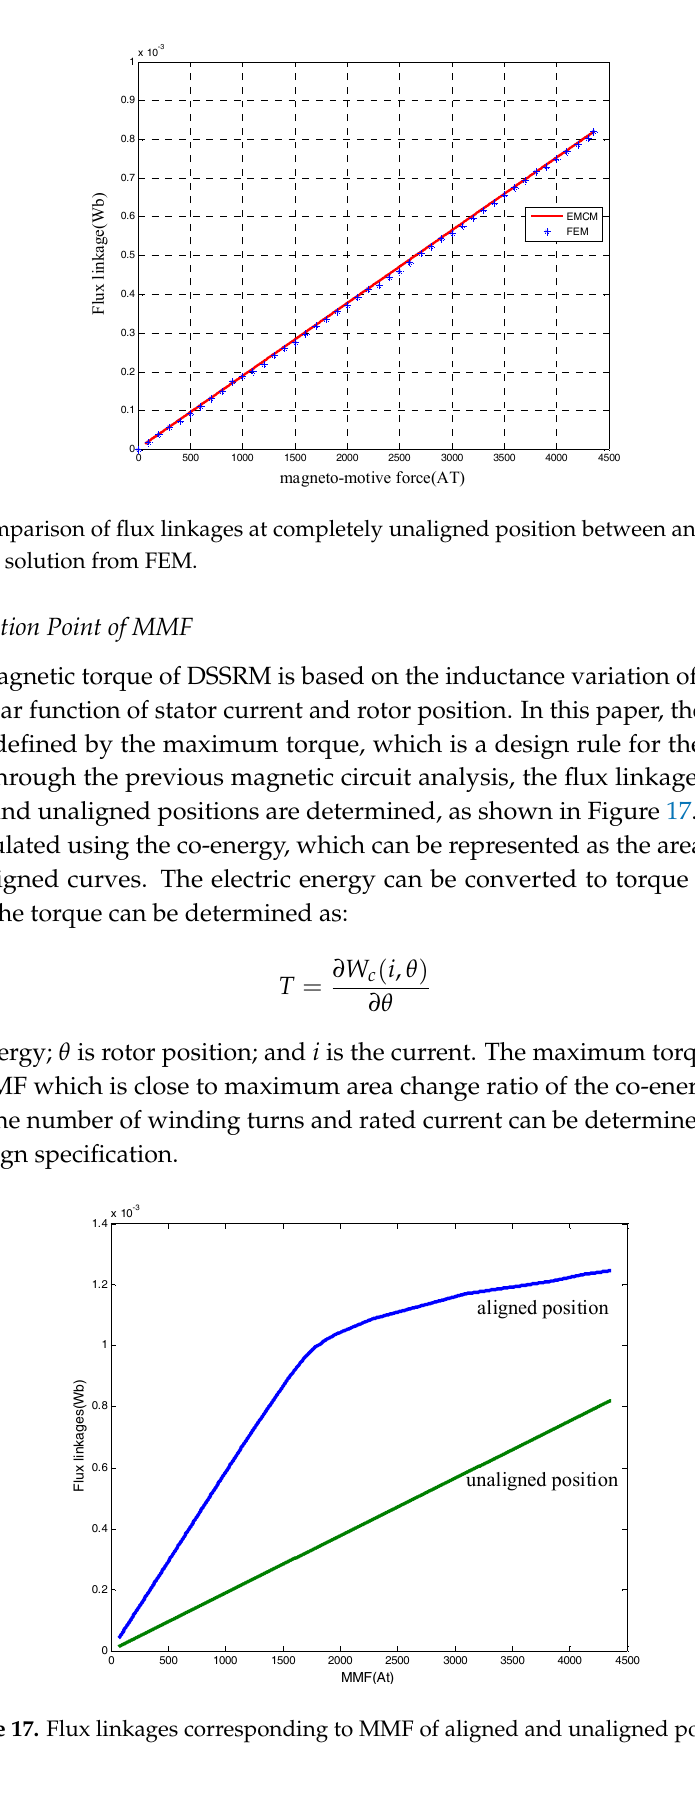
Figure 15. Comparison of the 2D total magnetic potential vector between analytical solution and numerical solution from FEM.